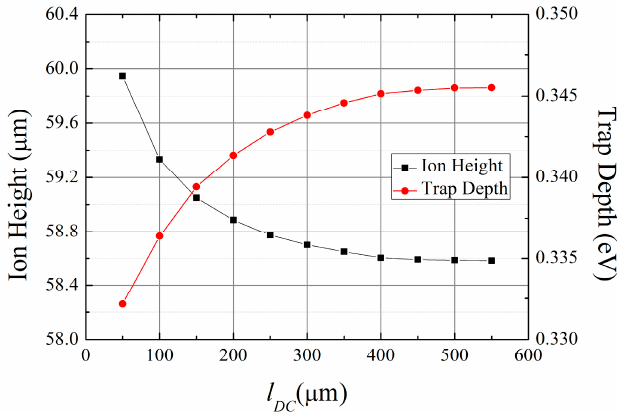
Figure 6. Simulation results for the trap depth and ion height as a function of the length of the DC electrodes. We fix a and b at 50 µ m and 200 µ m, respectively. The ion species assumed in the simulations is 171 Yb + .